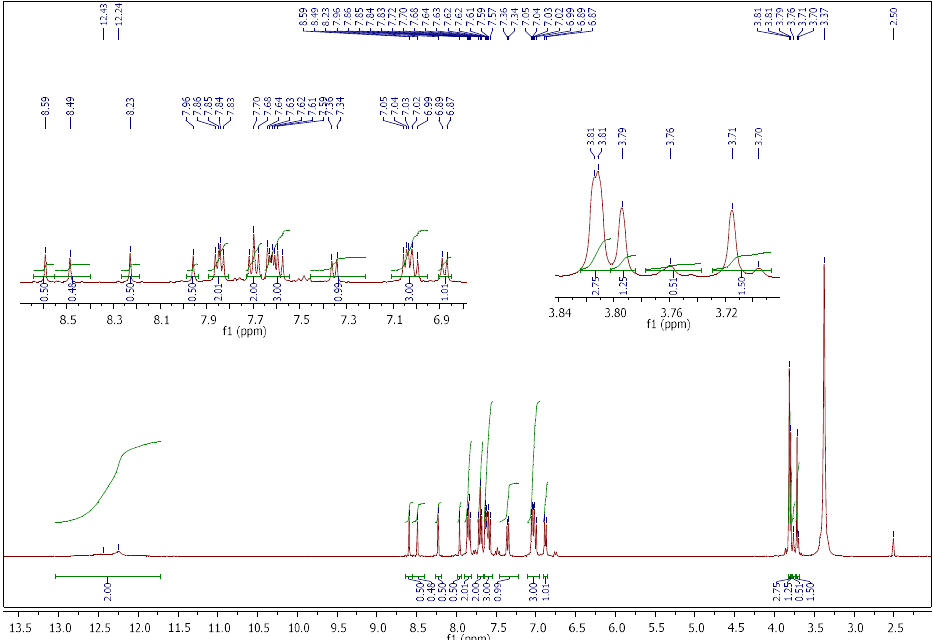
Figure 1. 1 H-NMR spectrum of compound 5f .